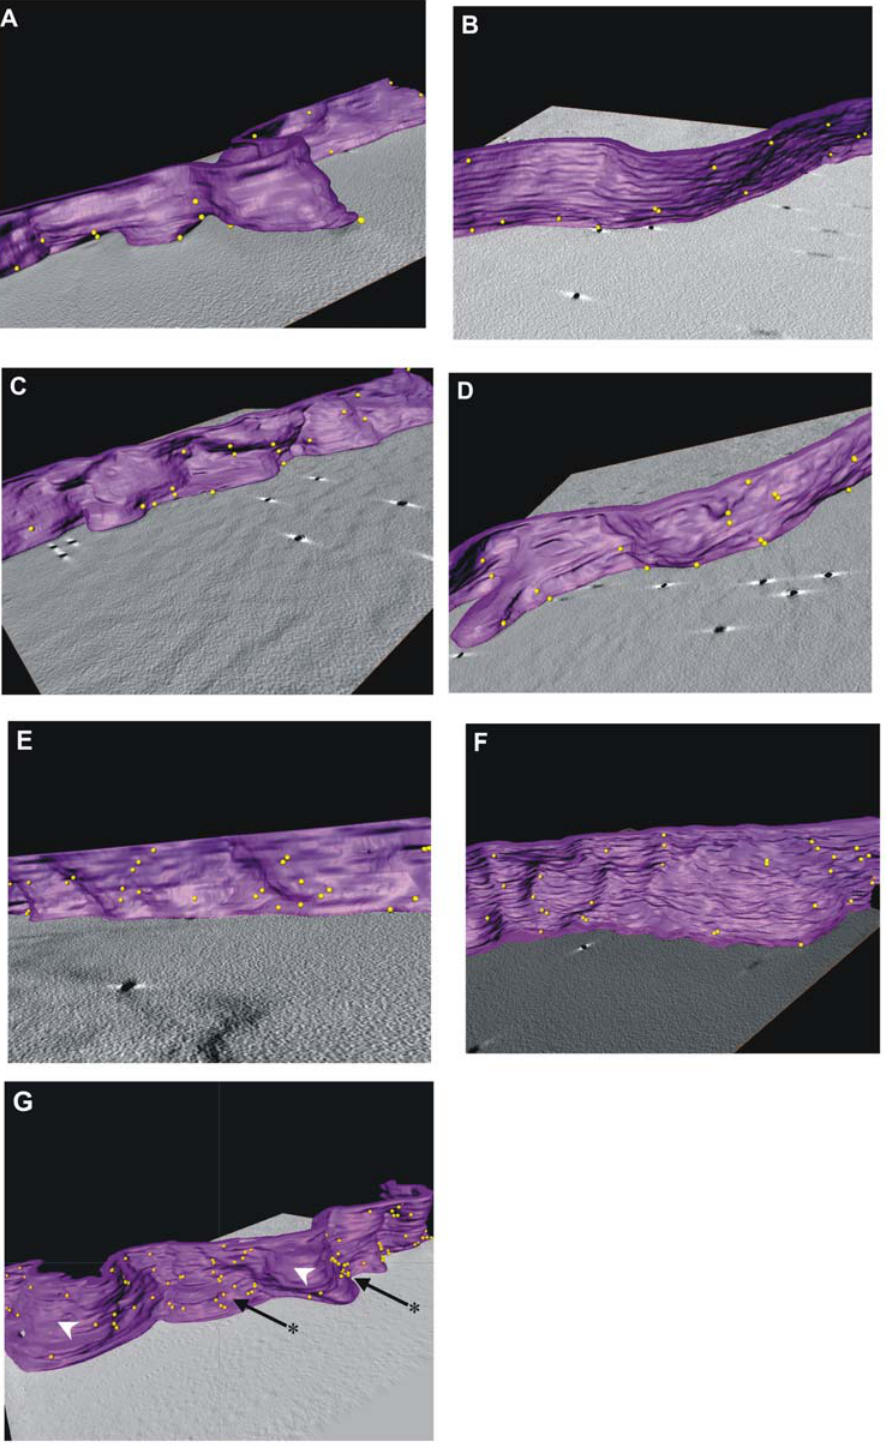
Figure 3. SEA does not mediate large-scale clustering of HLA-DR1 on B cells. B cells treated as in Fig. 2 were stained using anti-HLA-DR primary and gold-labeled secondary antibodies, fixed and analyzed. Representative tomograms of 250 nm thick sections of these cells were generated and segmented to highlight the 3D distribution of DR1 labeled by 6 nm gold beads ( gold spheres) on the B cell membrane ( purple ). B cells were untreated ( A ), treated with SEA + Zn 2 + ( B ), SEA + EDTA ( C ) or SEH ( D ). Representative stretches of cell membrane with a higher density of DR1 in cells treated with SEA ( E ), or untreated B cells ( F ) also showed no aggregates. Forced crosslinking of DR1 (G) caused aggregation (capping) of DR1 in some areas (black arrow/asterisk) but not others (white arrowhead).